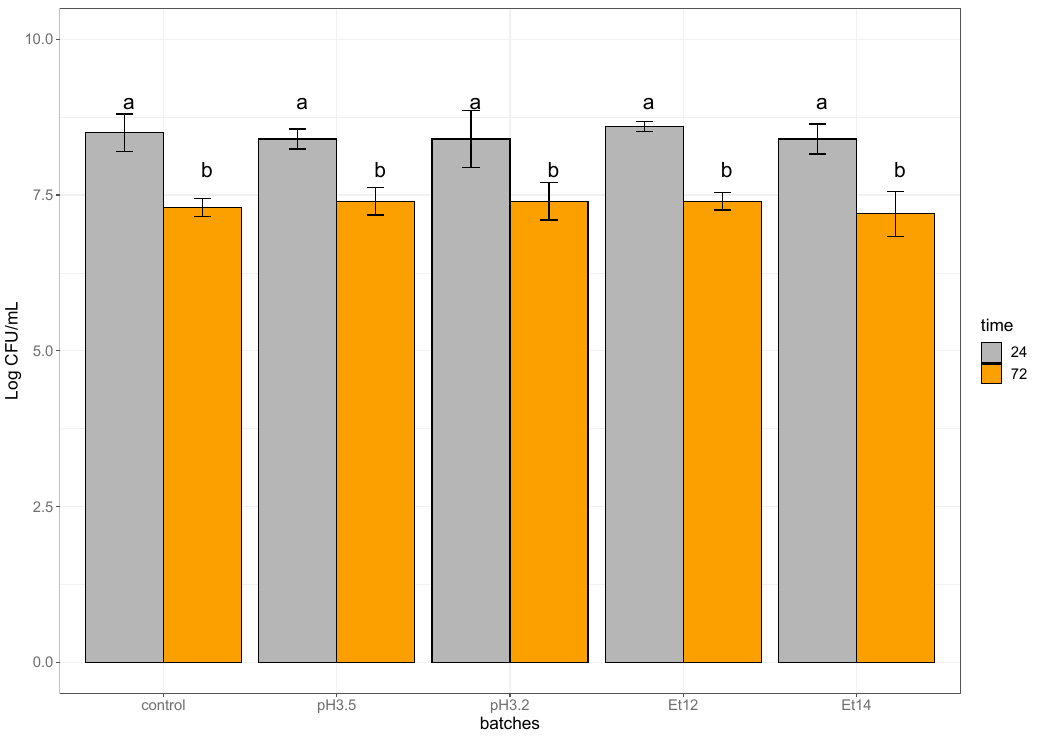
Figure 5. Mean values with standard deviation of L. plantarum strains belonging to high biofilm producer group. Cells were enumerated in the biofilms of 24 and 72 h, formed in MRS broth in presence of acid stress (pH 3.5, pH 3.2), ethanol stress (Et12, Et14), or without stress (control). Different letters indicate significant differences ( p < 0.05).